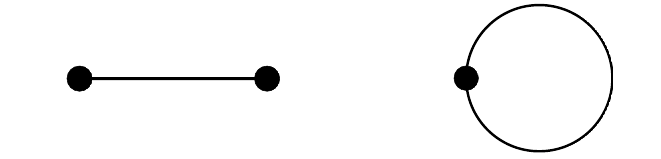
Figure 2 . Connected diagrams needed up to order 1 /λ for the evaluation of the path integral in eq. (2.21). The diagram on the left corresponds to eq. (2.24), while the loop on the right corresponds to eq.